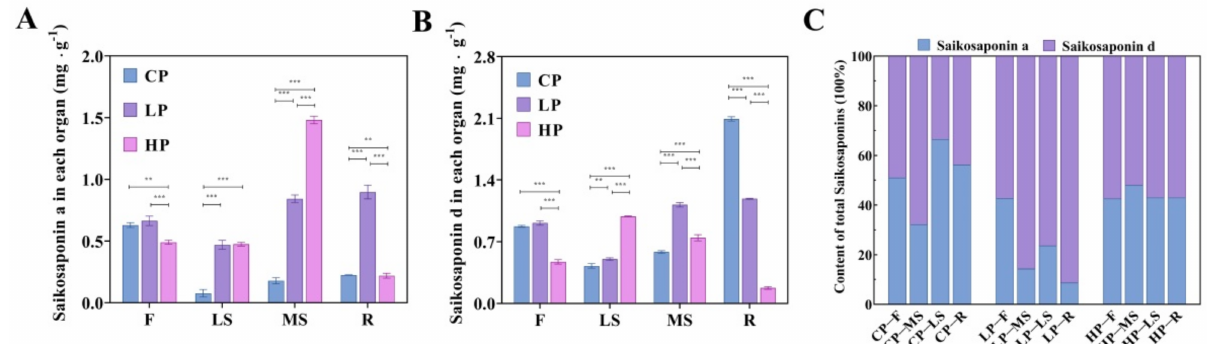
Figure 3. ( A ) Saikosaponin A analysis at three phosphorus fertilization levels and four organs. ( B ) Saikosaponin D analysis at three phosphorus fertilization levels and four organs. ( C ) The percent- age of saikosaponins content, including saikosaponin A and D. Three phosphorus fertilization levels: low phosphorus (LP), control phosphorus (CP) and high phosphorus (HP); and Four organs: flower (F), main shoot (MS), lateral shoot (LS) and root (R). ** represent p < 0.01; *** represent p < 0.001.